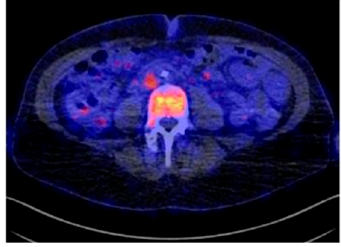
Figure 5. Representative PET/CT image of bone metastasis of a Triple-Negative Breast Cancer patient with [89Zr]atezolizumab on day 7 post injection (SUVmax 7.1). (Figure adapted from Bensch F et al. (2018) [70], Permission number 4691820293672, © Springer